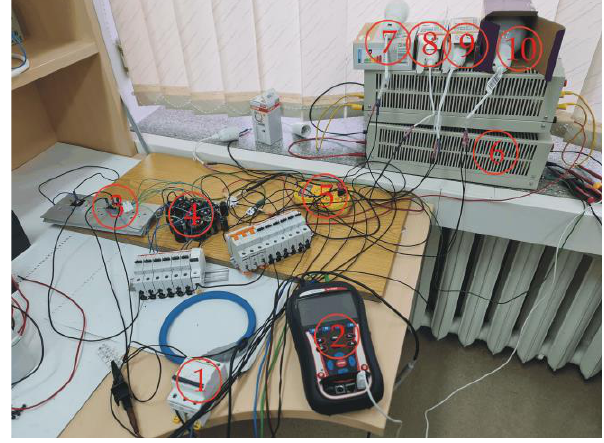
Figure A8. Photo of experimental setup for the reactive power provided or drawn out by LED light